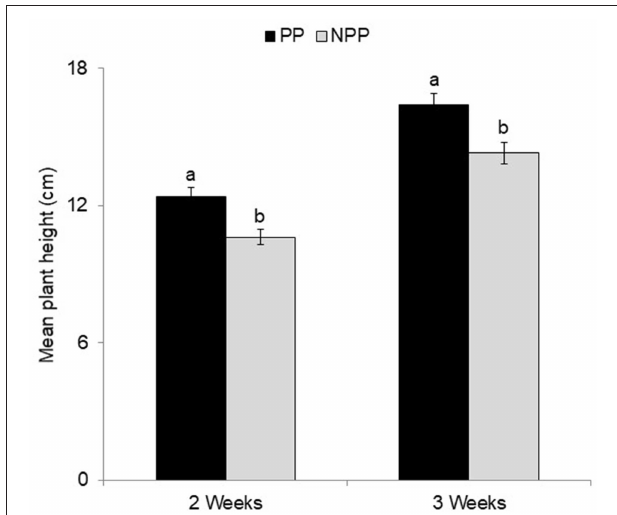
FIGURE 2 | Mean ( ± SEM) maize plant height at 2 and 3 weeks after planting in different soil types obtained from different cropping systems showing the overall effect of soil conditioning from Push-Pull (PP) and Non-Push-Pull (NPP) cropping systems. N = 88 maize plants. Different letters above the bars indicate a significant difference between the means ( P <